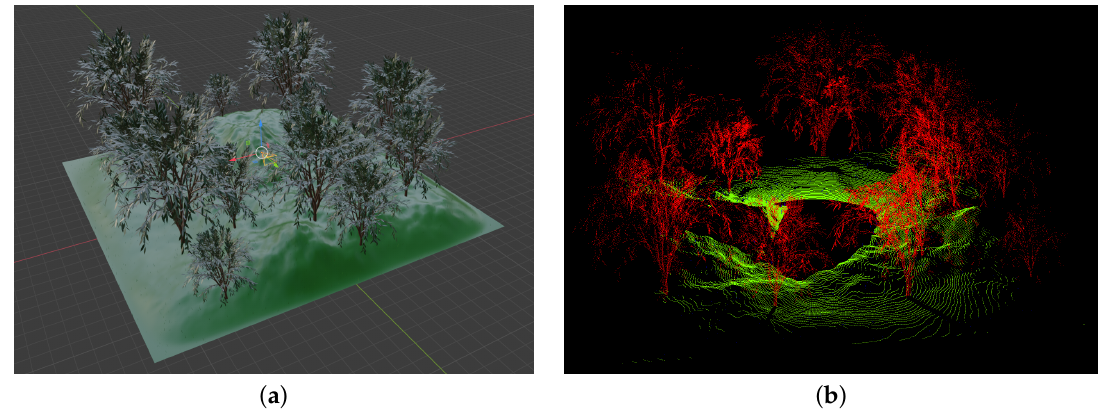
Figure 20. ( a ) Landscape scene with multiple trees. The simulated UltraPuck sensor is positioned in the center of scene. It has a horizontal field of view of 360° and vertical field of view of 40° ˙ ( b ) Semantically labeled point-cloud generated by BLAINDER. Trees in red, ground in